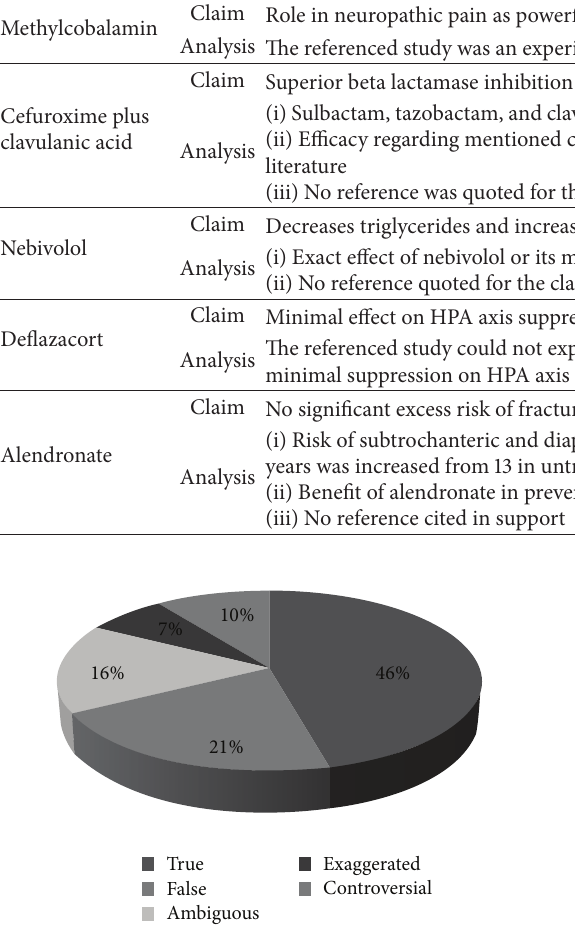
Figure 1: Categorization of claims in drug promotional advertise- ments.